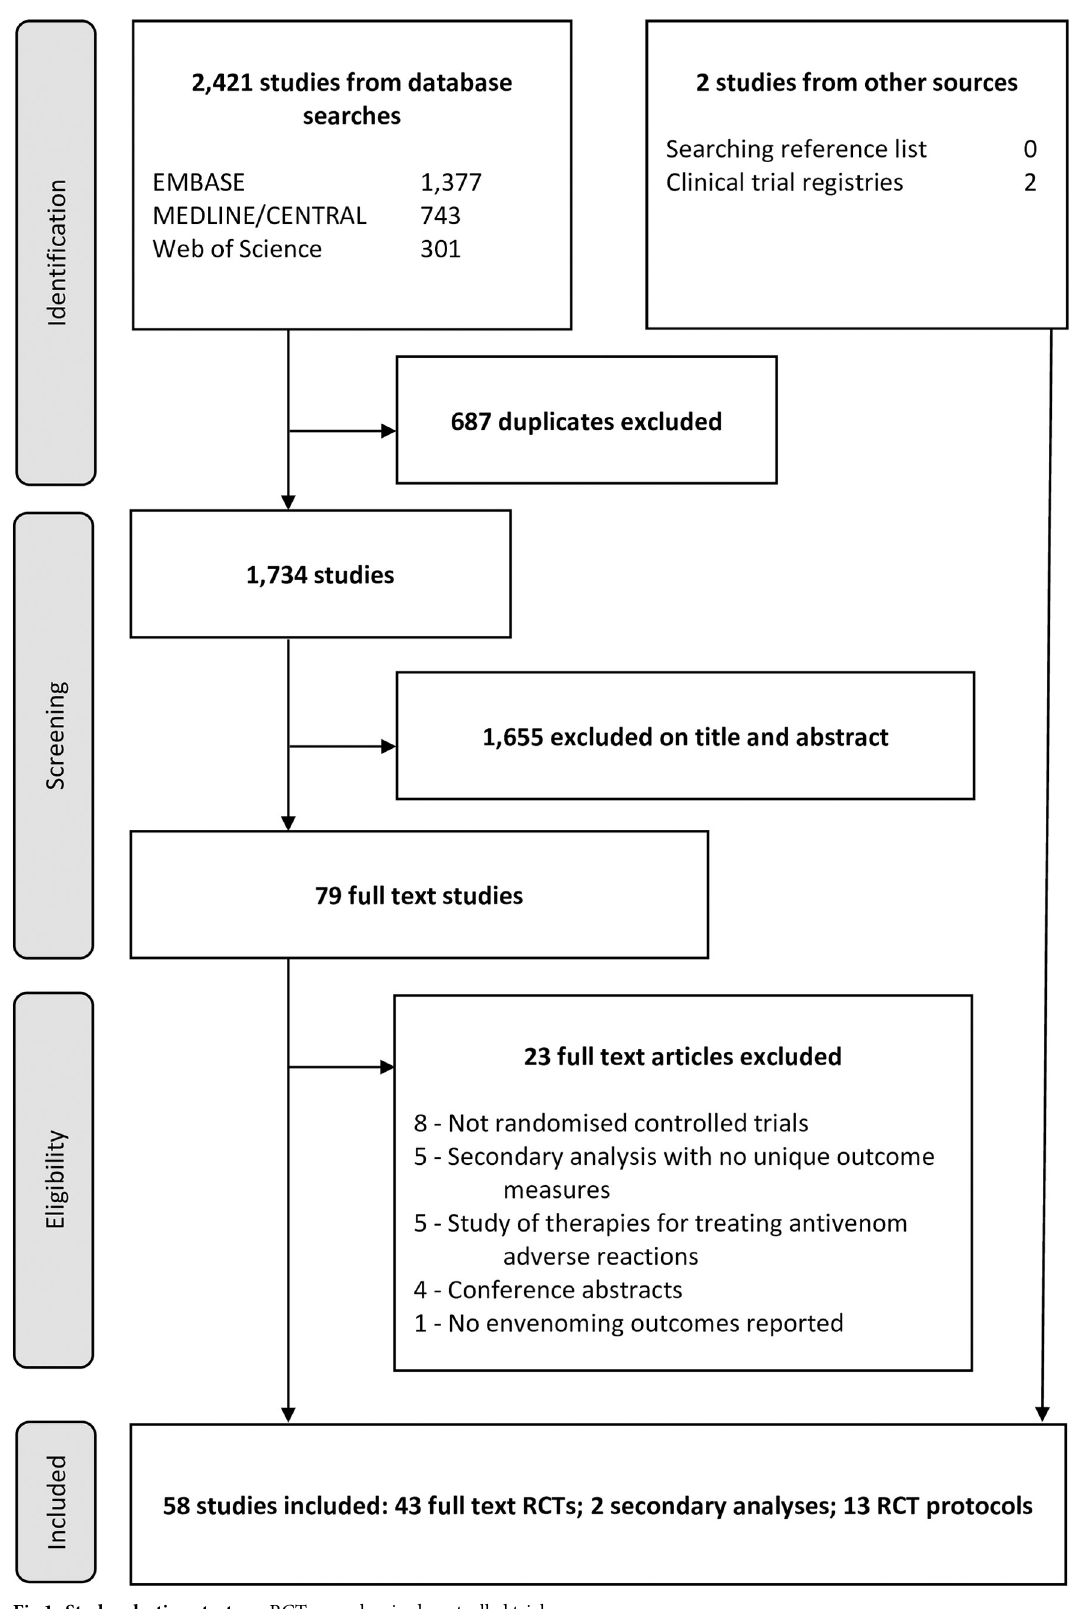
Fig 1. Study selection strategy. RCT = randomised controlled trial. https://doi.org/10.1371/journal.pntd.0009589.g001 PLOS NeglectedTropical Diseases | https://doi.org/10.1371/journal.pntd.0009589 August 2,